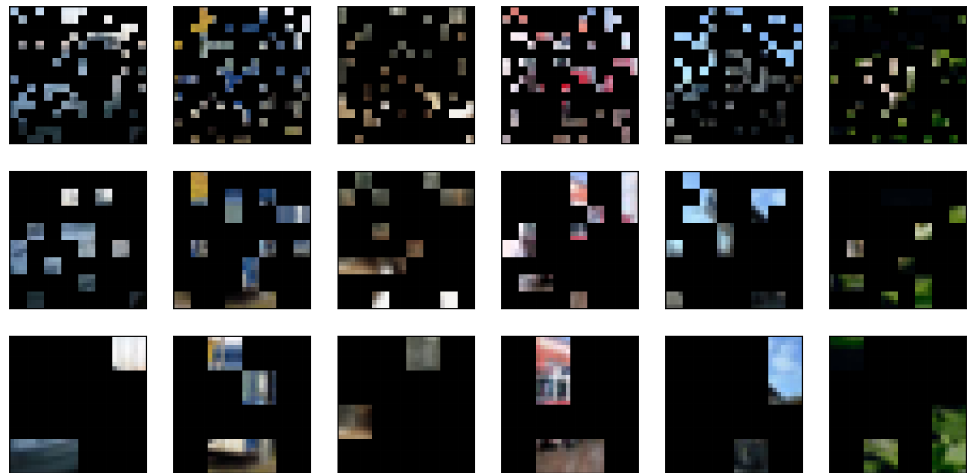
Figure 5. The 3/4 masked images from CIFAR-10 with different grid sizes: from top to bottom, 2 × 2, 4 × 4 and 8 × 8 grids are used for masking the same